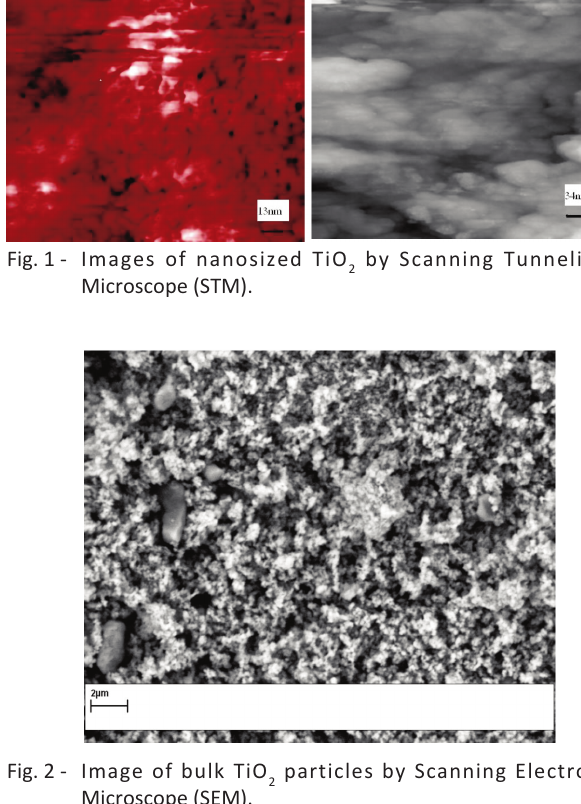
Fig. 2 ­ Image of bulk TiO particles by Scanning Electron 2 Microscope